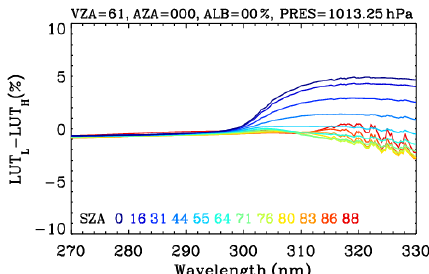
Figure 8. Example of LUT-based correction